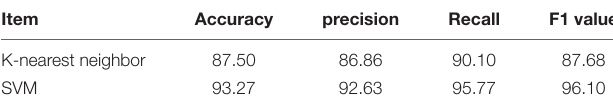
TABLE 10 | EEG classification performance (%) for different